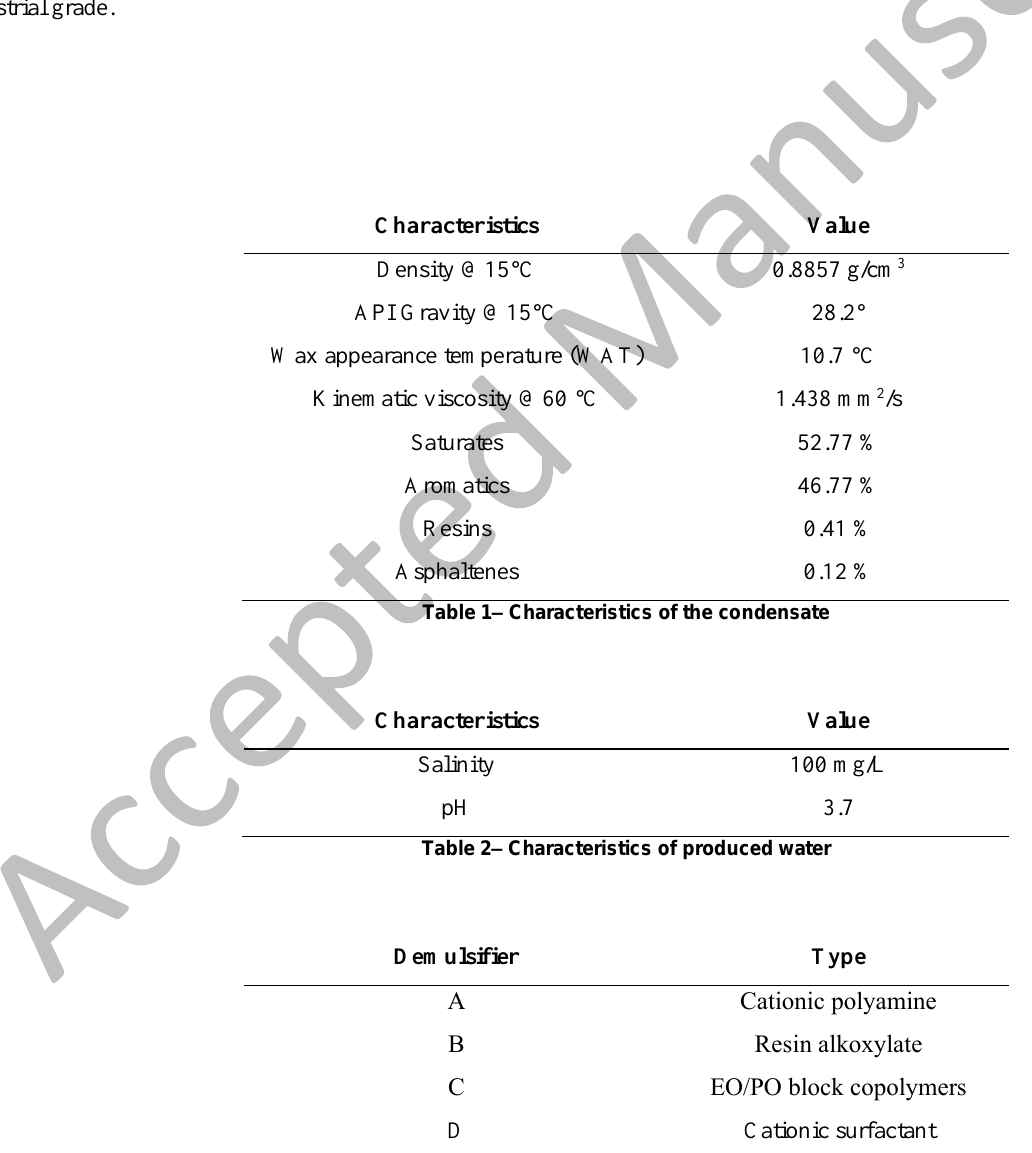
Table 2– Characteristics of produced water